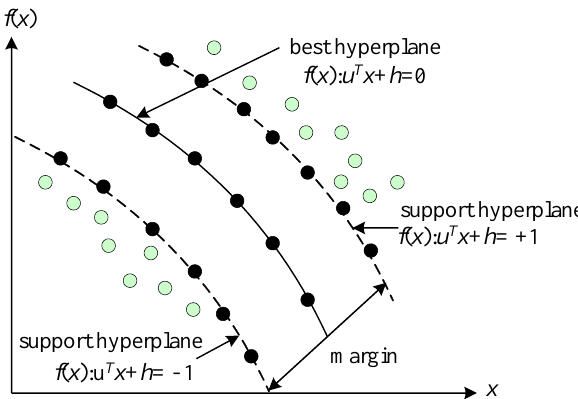
Figure 4. The hyperplane for SVR.